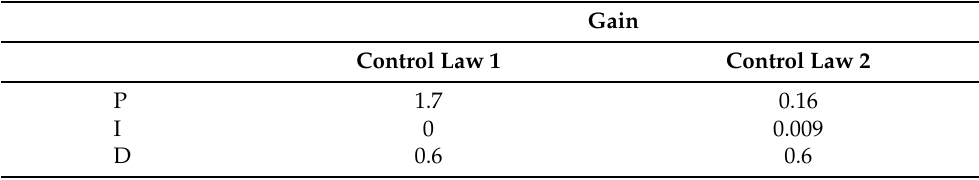
Table 1. Gain for the altitude control law.